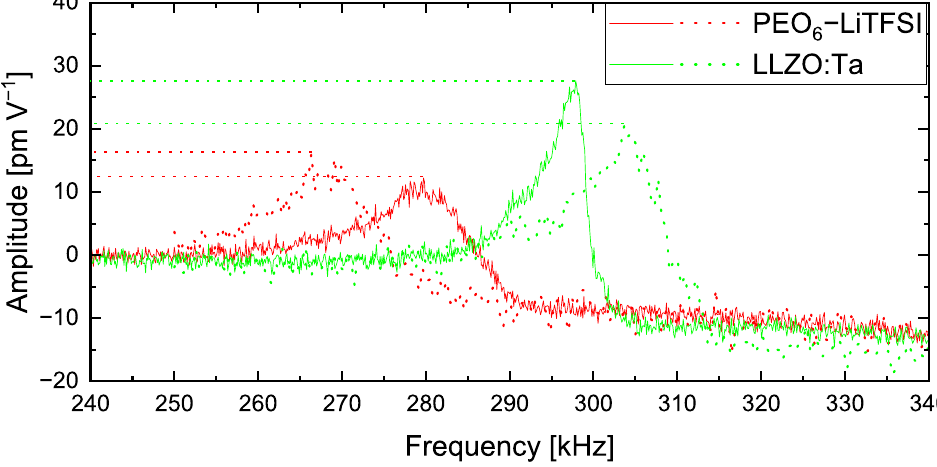
− LiTFSI (red) and LLZO:Ta (green). 6